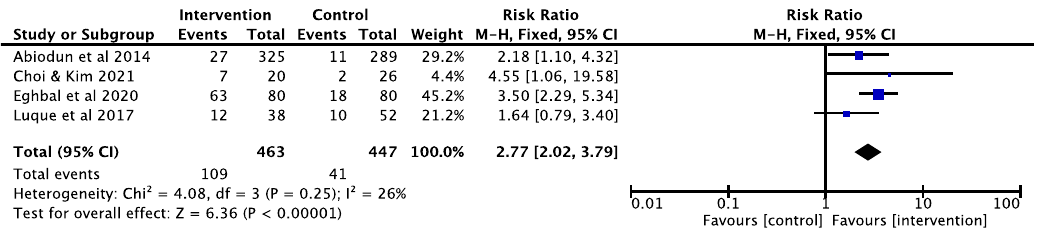
Figure 3. Effects of educational interventions on cervical cancer screening uptake (Quasi-experimental studies).